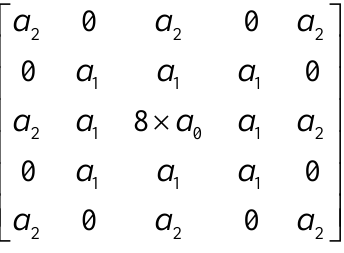
Figure 4. The 5 × 5 fractional differential operators in 8 directions.